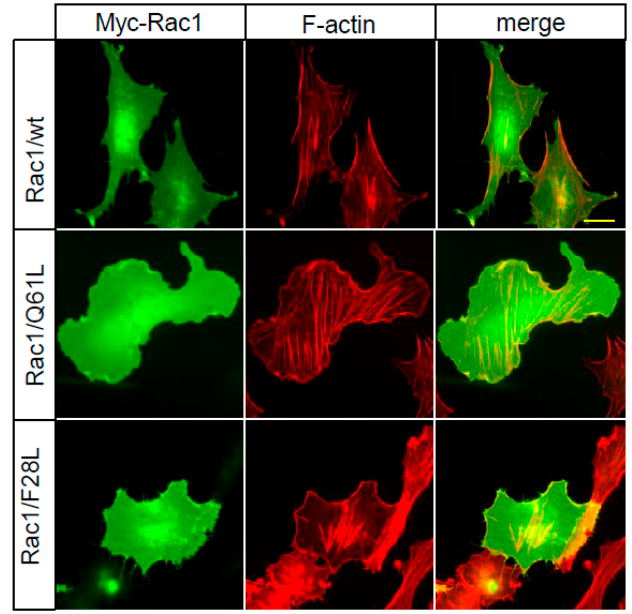
Figure 2. Rac1/F28L has a different effect on actin filament organization and cell morphology compared to Rac1/Q61L. Porcine aortic endothelial cells were transfected with Myc-constructs expressing Rac1/wt, Rac1/Q61L or Rac1/F28L. Myc-tagged Rac1 was visualized using a mouse anti-Myc antibody, followed by an Alexa Fluor 488-conjugated anti-mouse antibody. Filamentous actin was visualized with TRITC-conjugated phalloidin. Scale bar, 20 µ